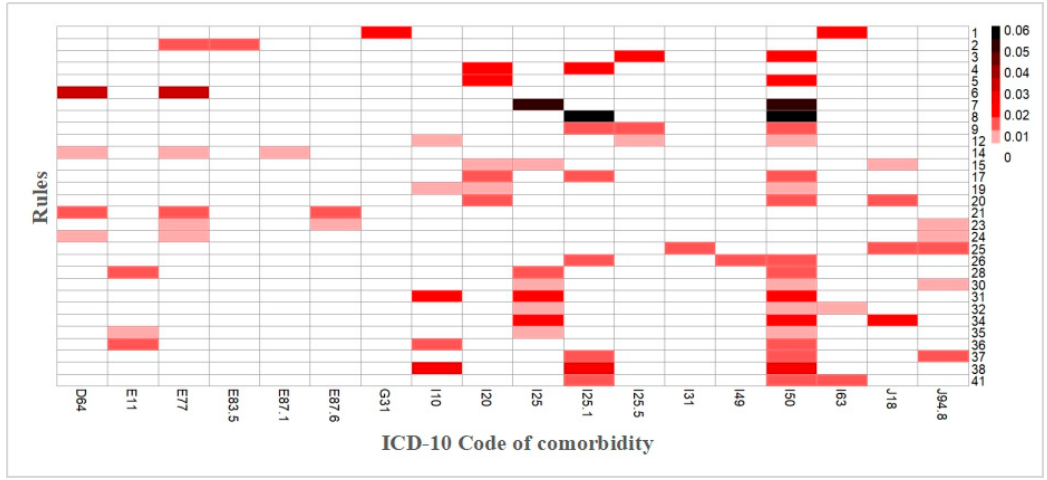
Figure 5. A heatmap showing the support values in the 41 derived association rules, where the rows are for the rules and the columns are for XX morbidities.